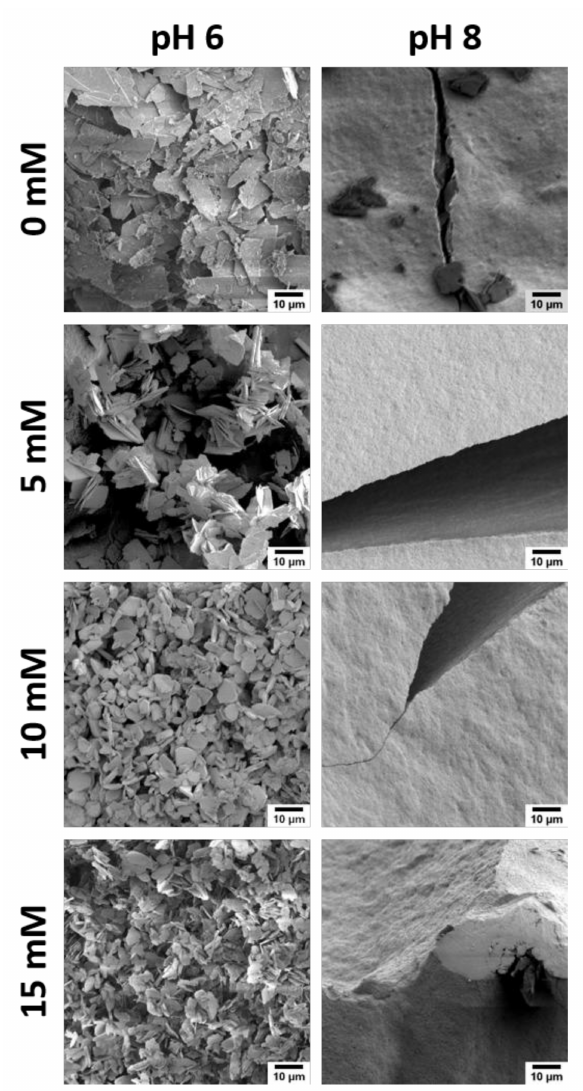
Figure 4. Representative SEM images of CP powders grown with EDTA. Note that the images of the control samples (grown without additive) are identical to those shown in Figure